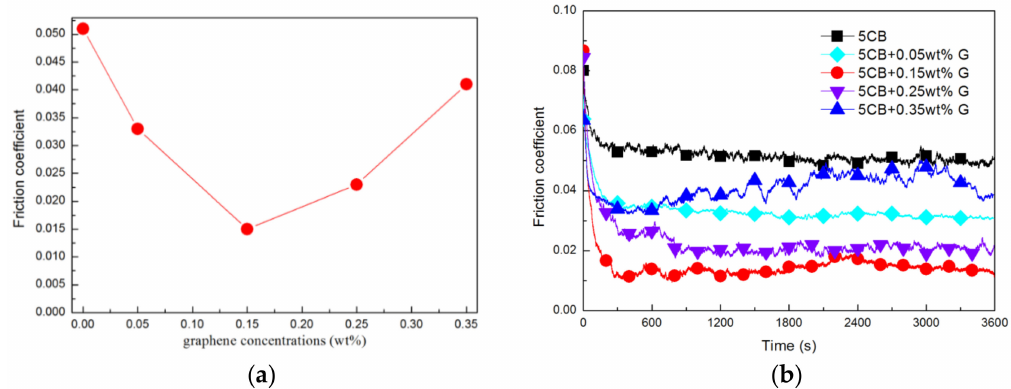
Figure 2. ( a ) Relationship between average friction coefficient and graphene concentration in 5CB, ( b ) relationship between friction coefficient and time at various graphene